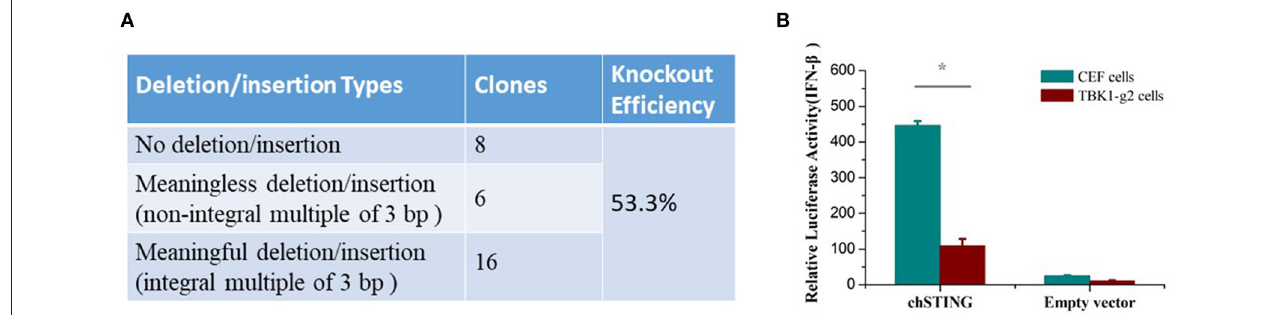
FIGURE 5 | The chTBK1 knockout system was applicable in CEFs. (A) Knockout efficiency of CEF cells transfected with TBK1-g2 were evaluated by cloning and sequencing. The knockout efficiency was calculated as “meaningful deletion or insertion clones/all clones.” (B) CEF or CEF-TBK1-g2 cells were cotransfected with either 100 ng/well of chSTING or empty vector with luciferase reporter plasmids. Luciferase assays were performed 24h after cotransfection. Asterisks indicate a significant difference ( p < 0.05) as determined by Student’s t -test.